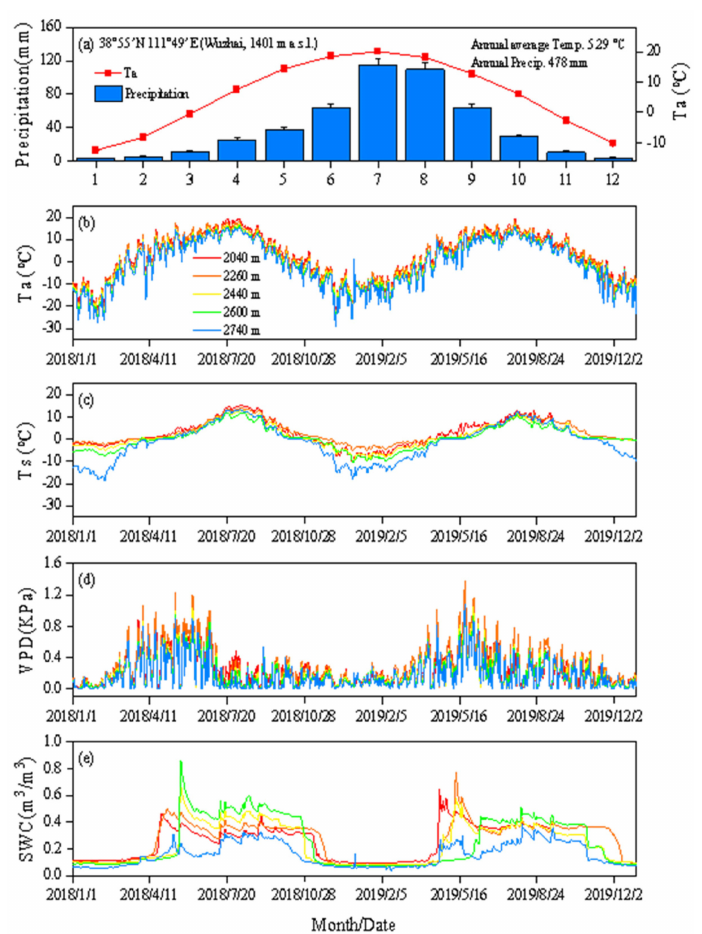
Figure 1. Seasonal changes in the mean monthly air temperatures and the mean monthly precipitation of 1957–2019 (mean ± SE) ( a ), daily mean of ( b ) air temperature (Ta), ( c ) soil temperature (Ts), ( d ) vapor pressure deficit (VPD), and ( e ) soil water content (SWC) at each site in 2018 and 2019. Table 1. Tree properties at the five monitoring sites (mean ± SD). DBH: diameter at breast height. Altitude (m